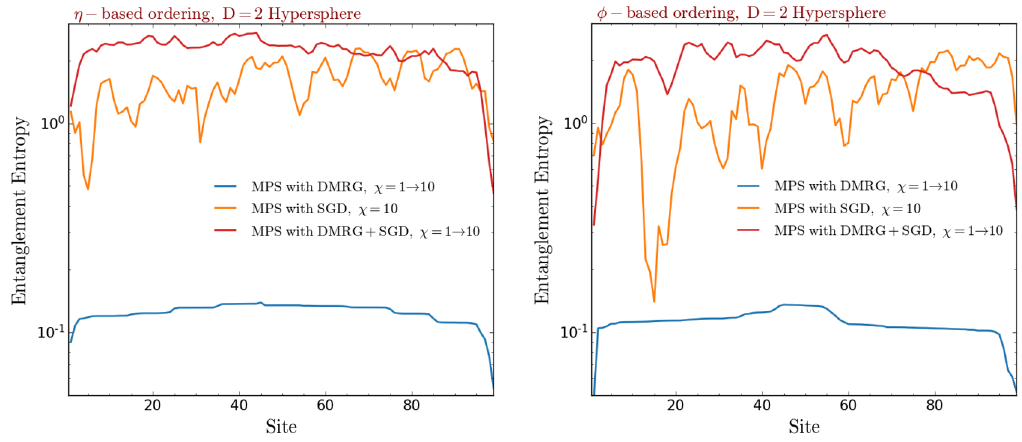
Figure 13 . The left panel shows the entanglement entropy for η -based ordered MPS where blue, red, and orange curves correspond to the MPS trained by DMRG, DMRG+SGD and SGD algo- rithms, respectively. The right panel shows the same for φ -based ordered